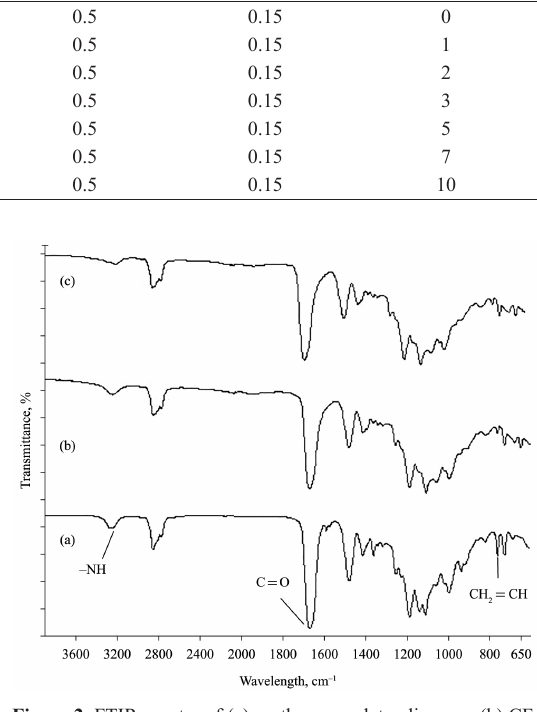
Figure 2. FTIR spectra of (a) urethane acrylate oligomer, (b) CF, and (c) UA -10